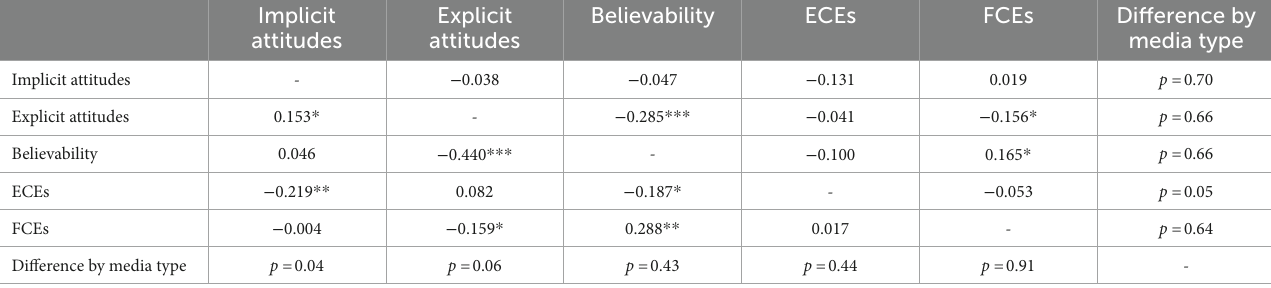
TABLE 4 Correlations between continuous variables in study two; Results for men are below the diagonal and the women’s results are above the